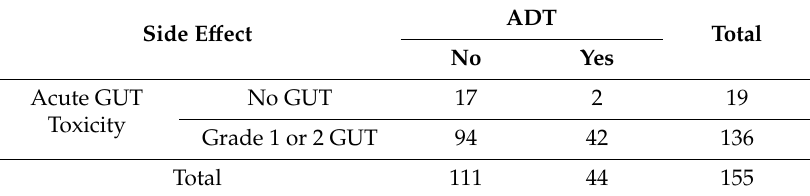
Table 3. Genitourinary toxicity